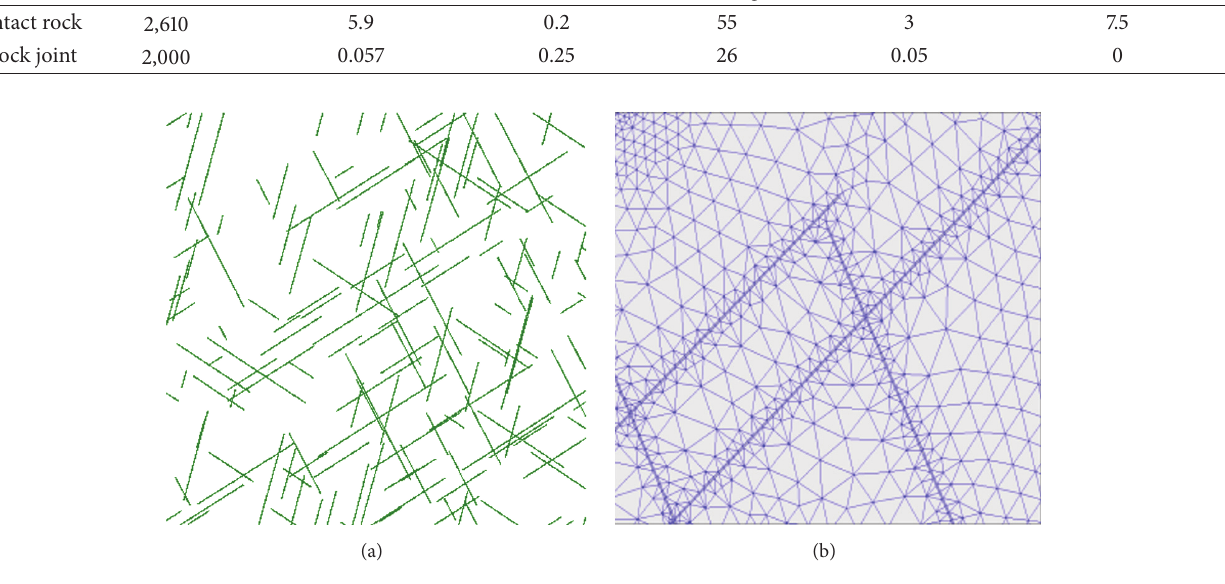
Figure 12: A stochastic joint network and local grids.